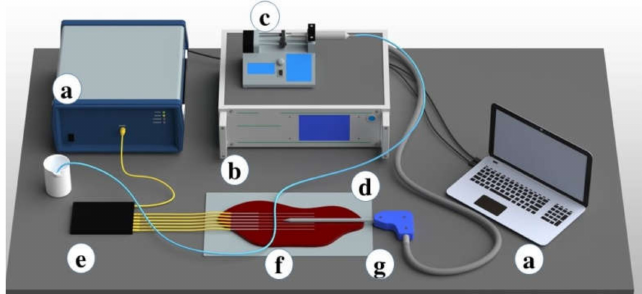
Figure 2. Zoomed schematic of the positions of the optical fibers, medical tube, and the active electrode. The schematic includes ( a ) six optical fibers positioned in y-axis in parallel at 4 mm distance; ( b ) a bovine liver; ( c ) a medical tube mimicking the blood vessel positioned in parallel to optical fibers and active electrode; and ( d ) RF applicator (active electrode).